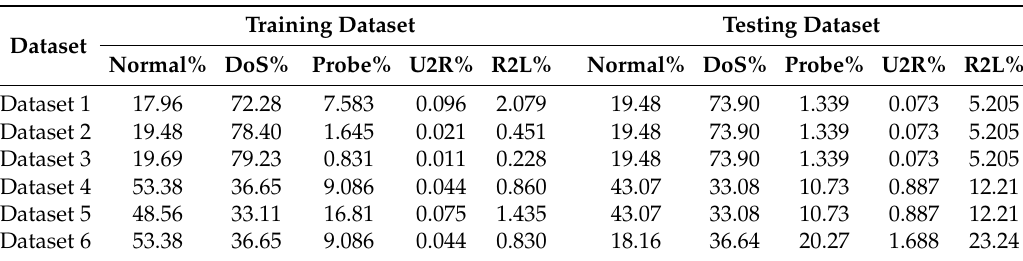
Table 1. The distribution of the training and testing sets from the six datasets generated from KDD’99 and